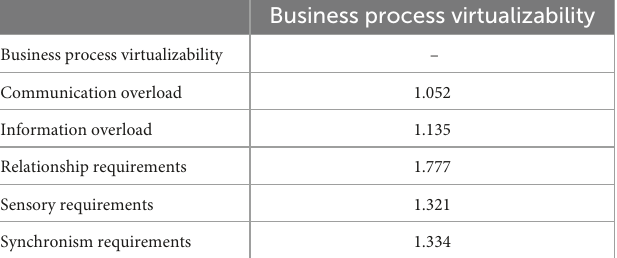
TABLE 4 Collinearity statistics variance inflation factor